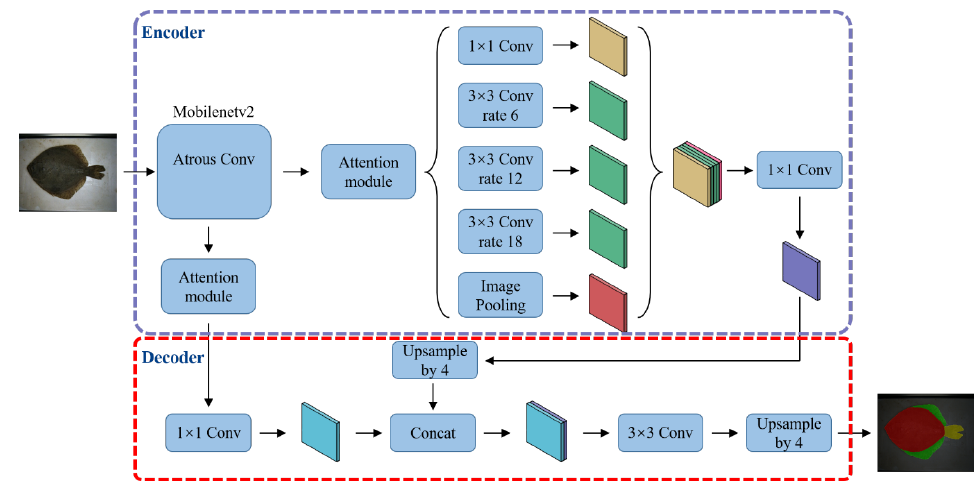
Figure 2. The network structure of Atten-Deeplabv3+.